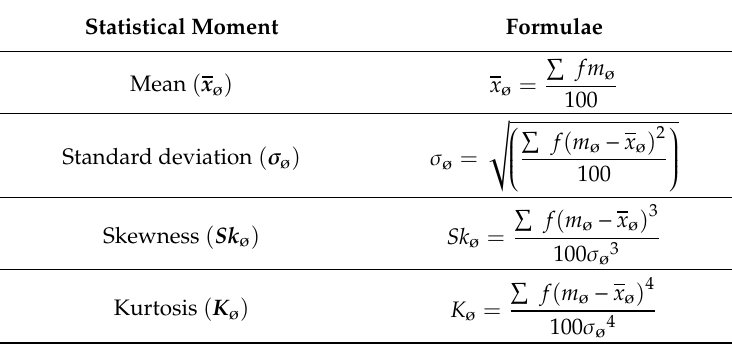
Table 2. Grain size of sediments collected on 13 December, 2017, classified according to the Udden– Wentworth [20,21], of each area in each study site. The average cumulative weight in percent in each class and the standard error are shown. WHA, area with hydrothermal activity; I, intermediate area; OHA, out of hydrothermal activity area.